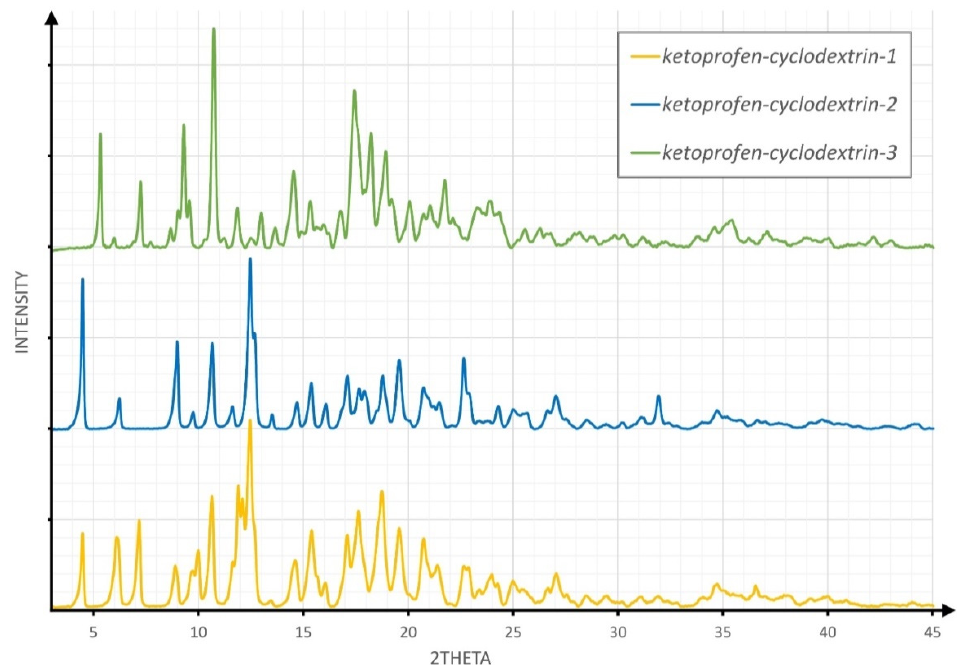
Figure 1. The comparison of X-ray powder diffraction (XRPD) patterns for powder products of three experimental procedures.